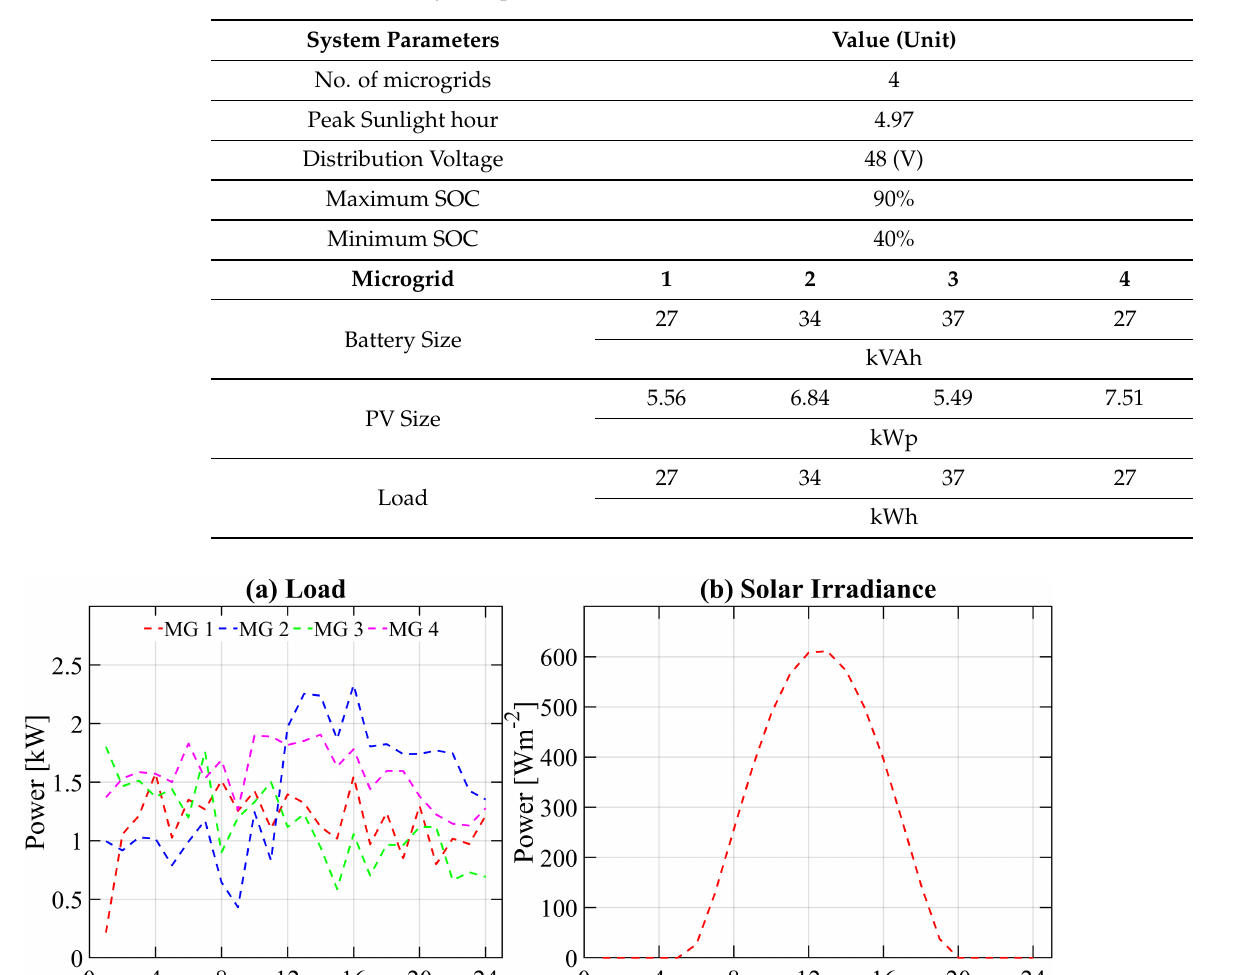
Table 1. The detail of system parameters.